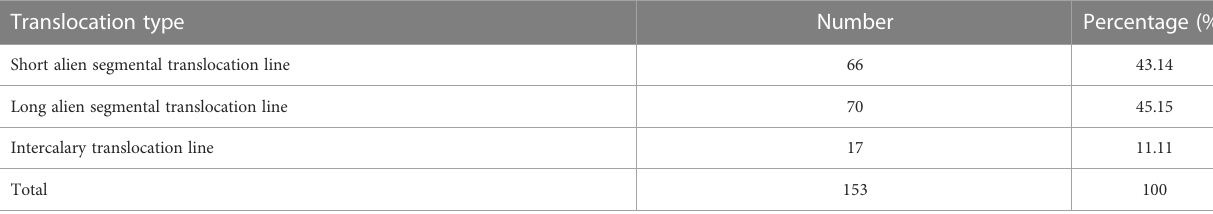
TABLE 1 Three types of translocation lines identi fi ed from 8,100 seeds.